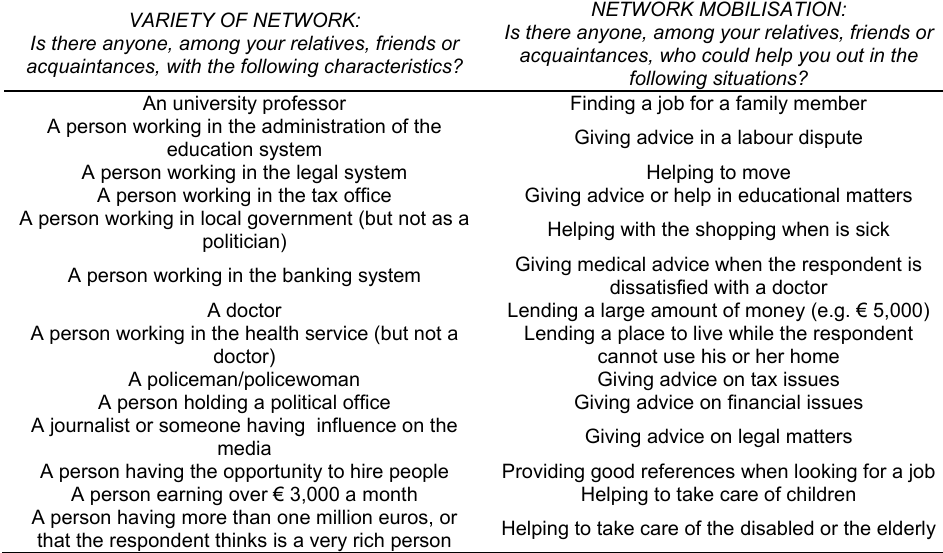
Table 1. List of items included in the measures of variety of network (Colum A) and the network mobilisation (Colum